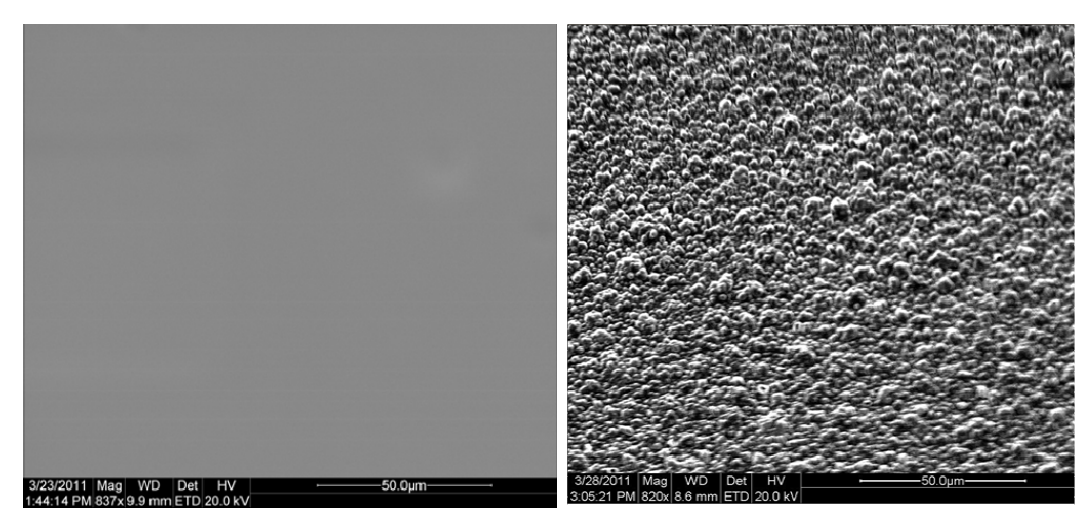
Figure 4. SEM images of Vinyloxy-100 before ( left ) and after ( right ) 48 h of water